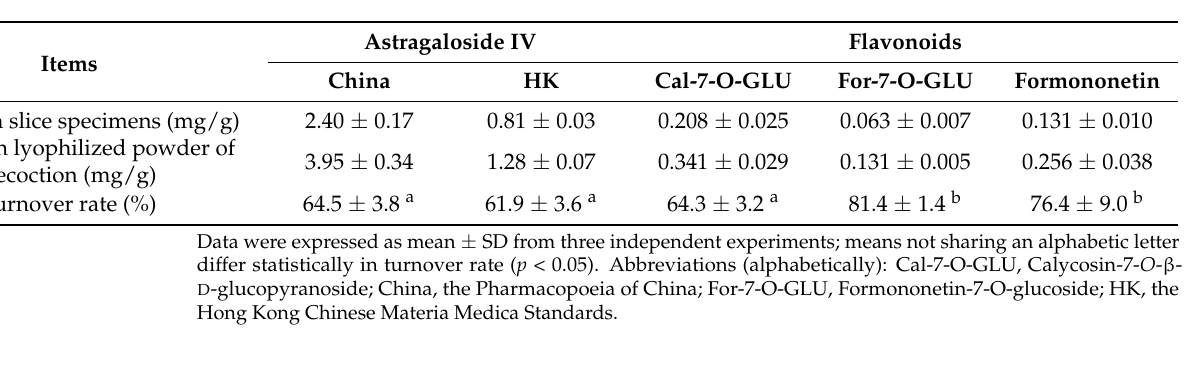
Figure 5. Correlation analysis between the active component content (Astragaloside IV and flavonoids) and the ratio of surface area in bark- and wood-tissue surface area in Astragali radix with different diameters. The surface area of bark and wood-tissue was calculated by Image J software and the surface area of bark was computed by subtracting wood-tissue from the total area. The ratio of surface area in bark and wood-tissue was calculated as bark area divided by wood-tissue area. Total flavonoids is the sum of Cal-7-O-GLU, For-7-O-GLU, and formononetin. Abbreviations (alpha- betically): Cal-7-O-GLU, Calycosin-7- O - β - D -glucopyranoside; China, the Pharmacopoeia of China; For-7-O-GLU, Formononetin-7-O-glucoside; HK, the Hong Kong Chinese Materia Medica Standards. Table 1. Turnover rate of Astragaloside IV and flavonoids from raw materials to decoction in AR with a diameter of 0.3–0.6